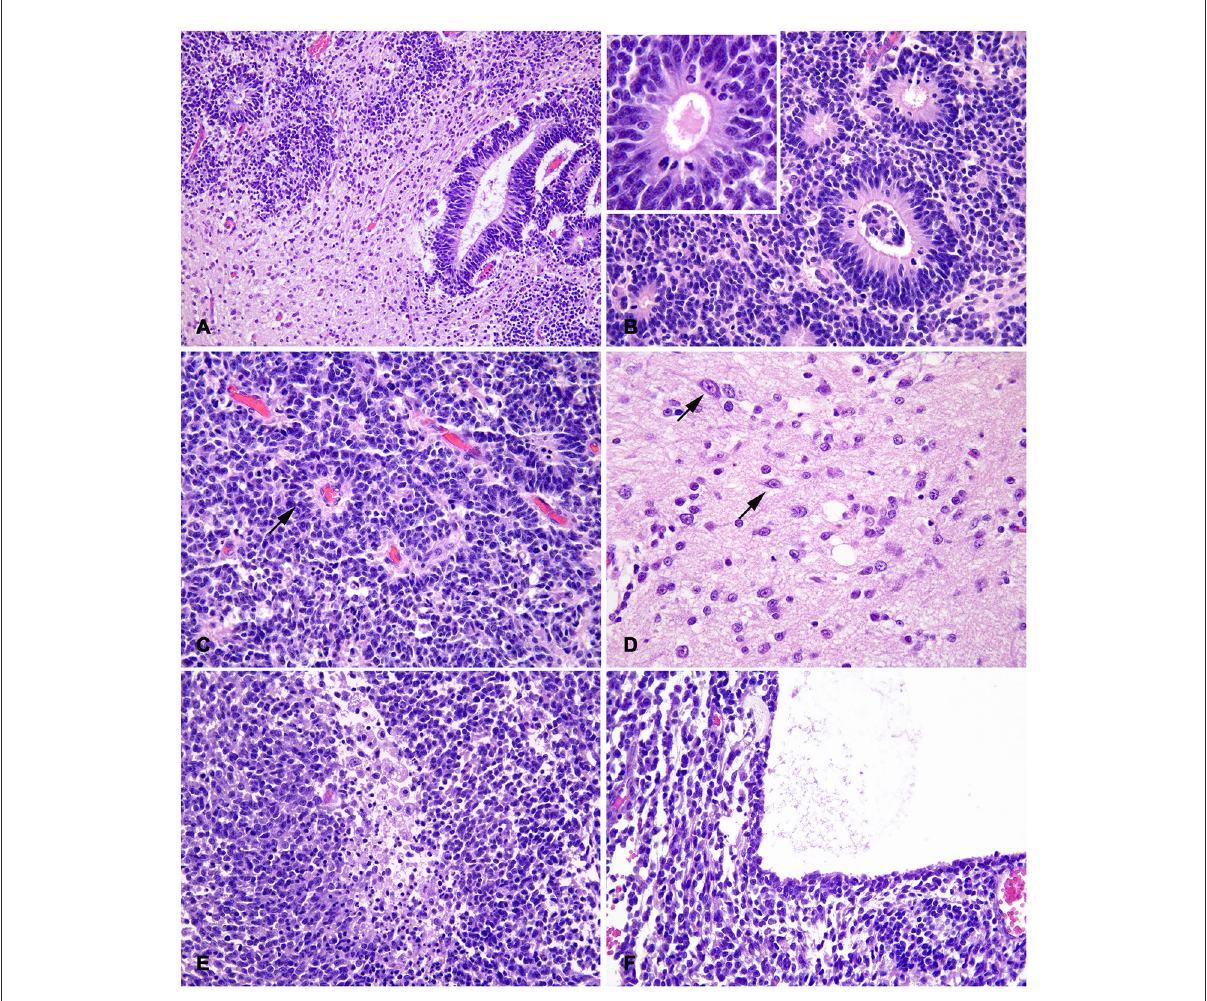
FIGURE2 Feline embryonal tumor with multilayered rosettes, neuropil-like areas and foci of neurocytic differentiation; histological aspects. (A) The tumor is composed by dense clusters of small-to-medium undifferentiated cells, paucicellular regions with fibrillary eosinophilic (neuropil-like) appearance and multilayered rosettes with slit-like or round lumens. (B) Rosettes have multiple peripheral nuclear layers and a central nuclei-free zone with frequent mitotic figures; central lumens are bounded by distinct cell membranes with eosinophilic contouring and debris (insert). (C) Irregular chords of undifferentiated cells have scant indistinct cytoplasm and form perivascular pseudorosettes (arrow). (D) In neuropil-like areas, rare scattered cells exhibit neurocytic differentiation (arrows). (E) Focal necrosis with macrophage infiltration in a densely cellular and highly proliferating area. (F) Part of the mass limiting the area of cystic degeneration, characterized by optically empty lumen with sparse eosinophilic debris. H&E